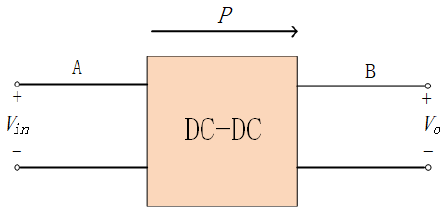
Figure 1. Non-isolated unidirectional DC-DC converters.